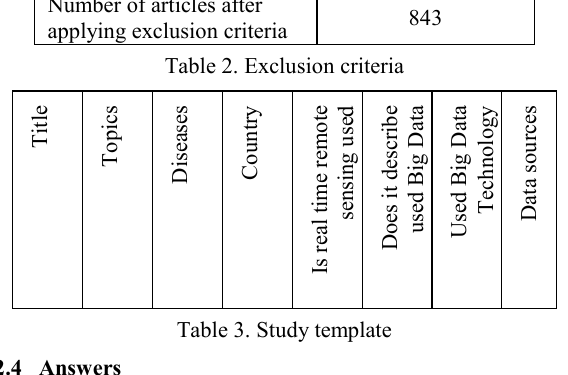
Table 2. Exclusion criteria